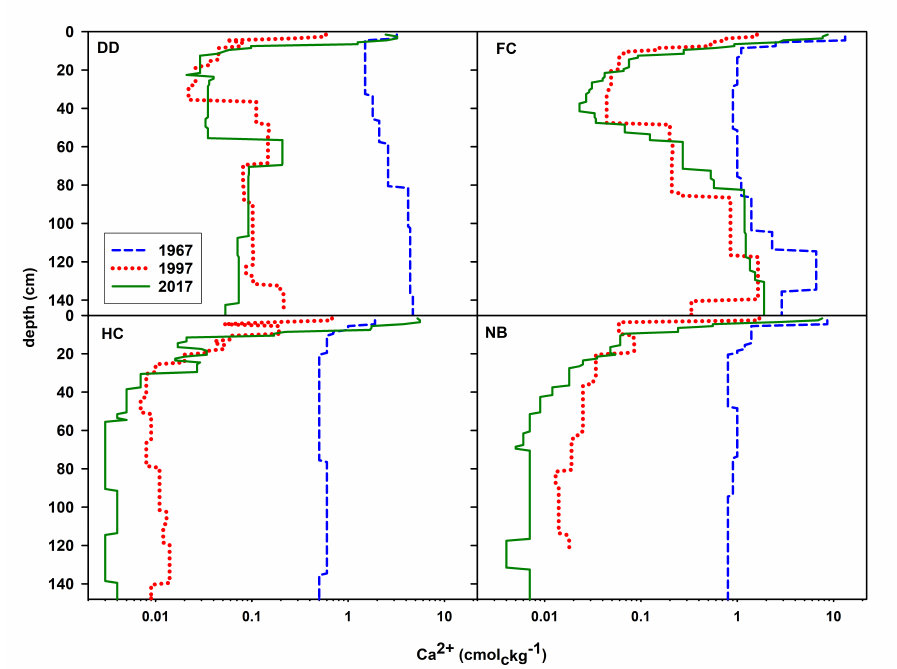
Figure 2. Soil exchangeable Ca